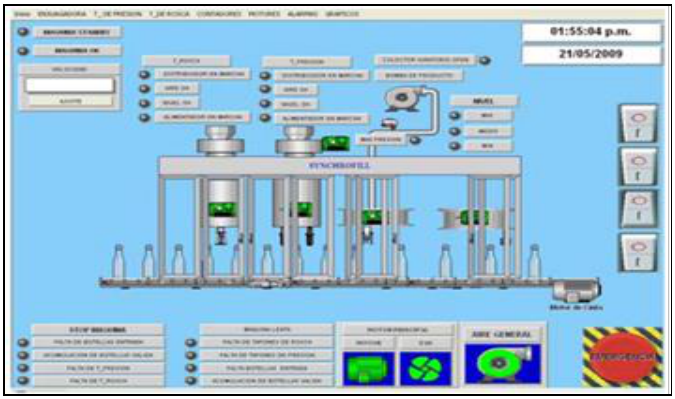
Figura 2: Monobloque. Fuente: Los Autores, (2018).